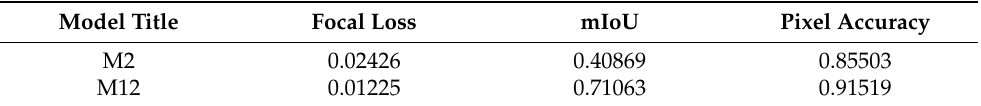
Table 2. Focal loss, mIoU, and pixel accuracy values for the coarse validation set after the training.